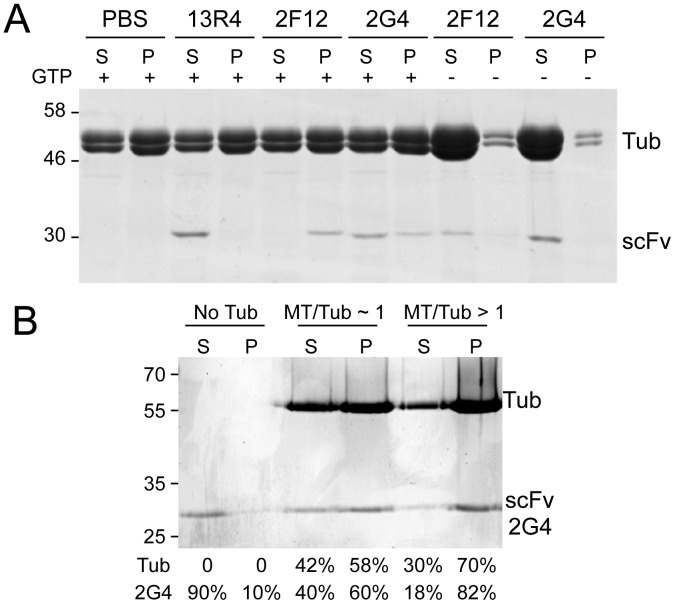
Purified 2G4 co-pellets with microtubules.Purified porcine brain tubulin was polymerized by addition of GTP and warming to 37°C. After incubation with purified scFv’s, the microtubule fraction was isolated by pelleting through a 40% sucrose cushion and the supernatants and pellets resolved on SDS-PAGE gels. The two anti-tubulin scFv’s, 2F12 and 2G4, co-pelleted with microtubules, but a greater fraction of 2F12 was pelleted compared to 2G4, consistent with comparatively weaker binding of 2G4 to microtubules. 13R4, an anti-ß-galactosidase scFv, did not co-pellet with microtubules, indicating that scFv are not trapped in the microtubule pellet. To confirm that co-pelleting represents binding to microtubules, GTP was omitted from the assembly mixture to significantly reduced tubulin polymerization. Under these conditions 2F12 and 2G4 are found in the supernatant fraction. B) To confirm that the fraction of scFv 2G4 present in the supernatant was active, we stabilized polymerized microtubules with Taxol in order to obtain a higher ratio of microtubules to soluble tubulin. The same experiment described in (A) was repeated in the absence (labeled “No Tub”), and in the presence of about equal concentrations of microtubules and tubulin (labeled “MT/Tub∼1”) and most tubulin polymerized into microtubules (labeled “MT/Tub>1”). The bands were quantified and the percentage of soluble tubulin, microtubules, and soluble and pelleted scFv are indicated below the lanes. Because of saturation of the Coomassie signal, tubulin quantitations are approximate and the percentage of tubulin in the pellet fraction is underestimated in the last lane.